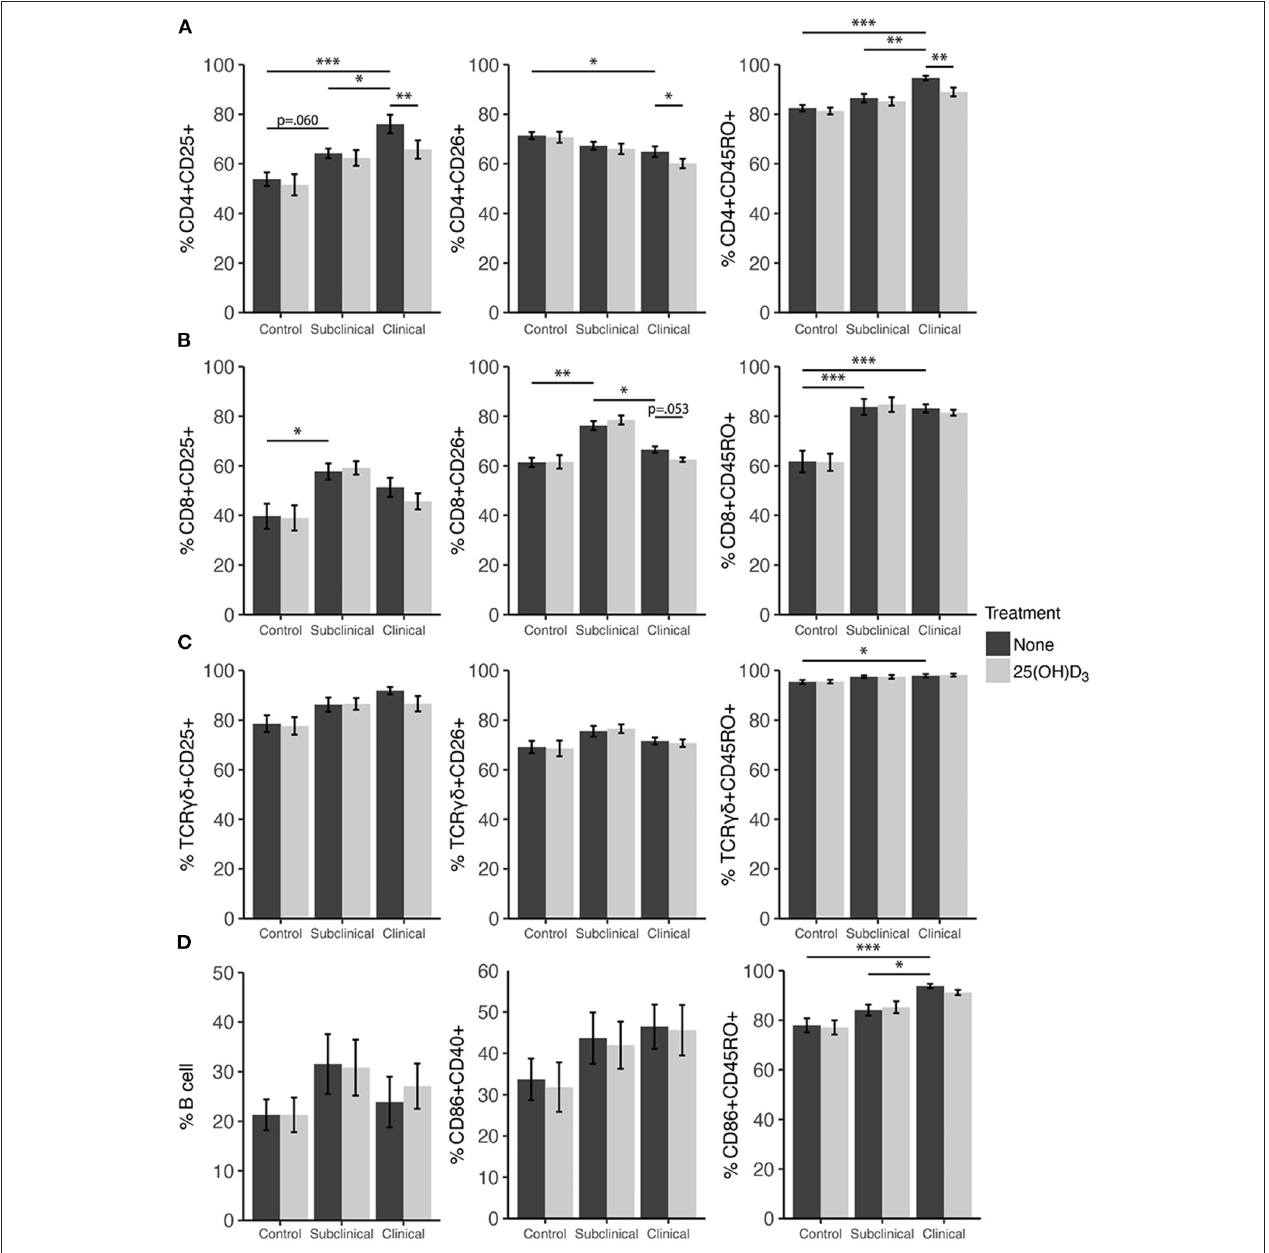
FIGURE 7 | Expression of activation and memory markers on the surface of (A) CD4 + , (B) CD8 + , (C) γδ T cells, (D) monocytes, and total B cells. Peripheral blood mononuclear cells were isolated from naturally infected dairy cattle (subclinical n = 8, clinical n = 8) or non-infected controls ( n = 8) and cultured 144h with whole cell MAP sonicate (MPS) ± 100ng/ml 25(OH)D 3 . Surface markers were detected using fluorescently labeled antibodies and a flow cytometer. Data are presented as the mean percentage ± SE and significance levels are as follows: * < 0.05, ** < 0.01, *** <